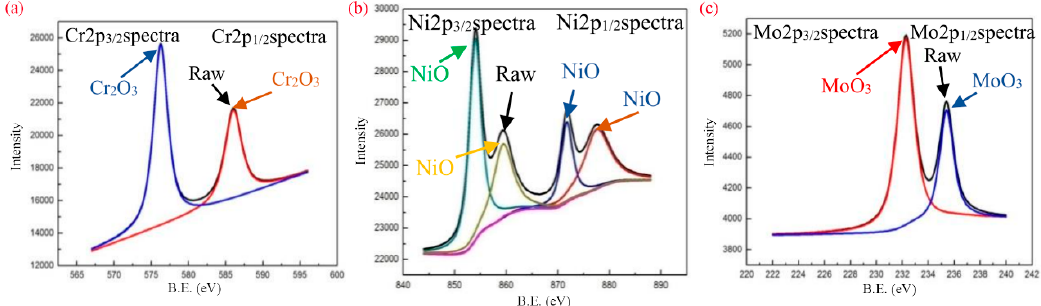
Figure 5. XPS results of the wear surface for the 1.0 wt. %Mo specimen: ( a ) Cr 2 O 3 ; ( b ) NiO; and ( c ) MoO 3 .